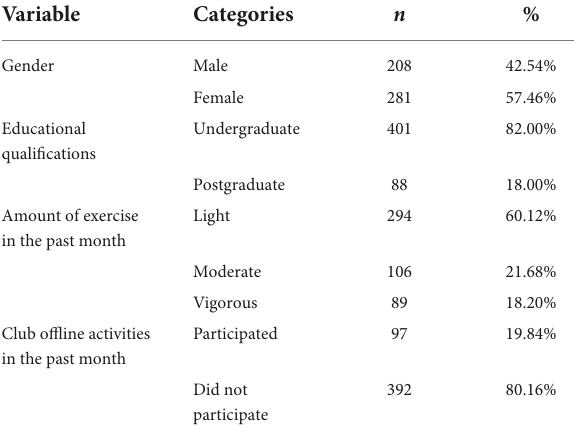
TABLE 1 Frequencies of demographics and amount of exercise.